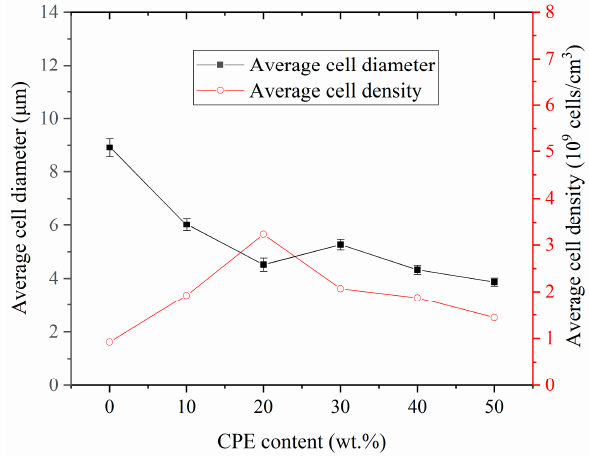
Figure 7. Average cell diameter and cell density of SAN/CPE composite foams.